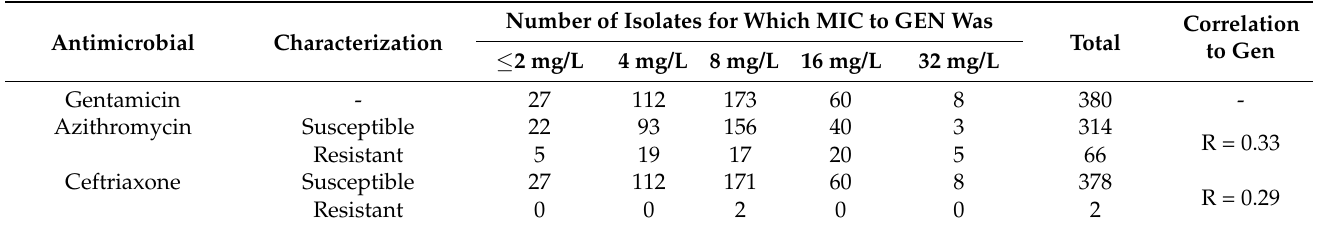
Table 1. N. gonorrhoeae isolates susceptibility to three antibiotics. (Gen, gentamicin). Antimicrobial